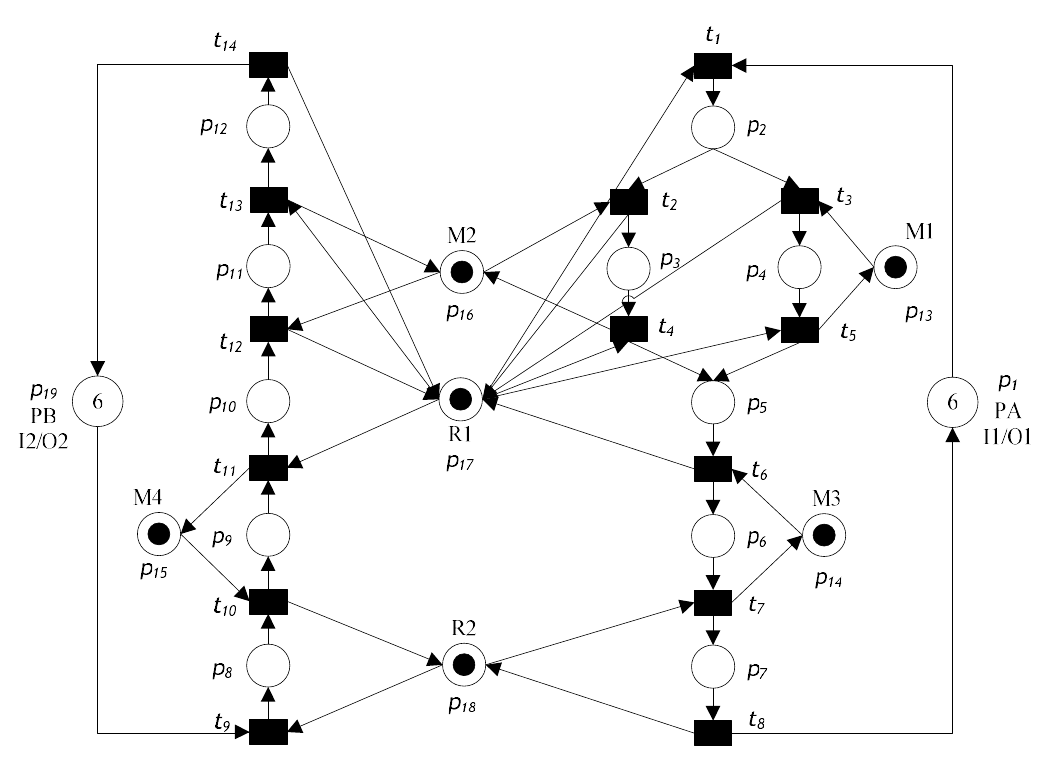
Figure 16. S 3 PR net ( N o , M o ) of the AMS illustrated in Figure 13a.